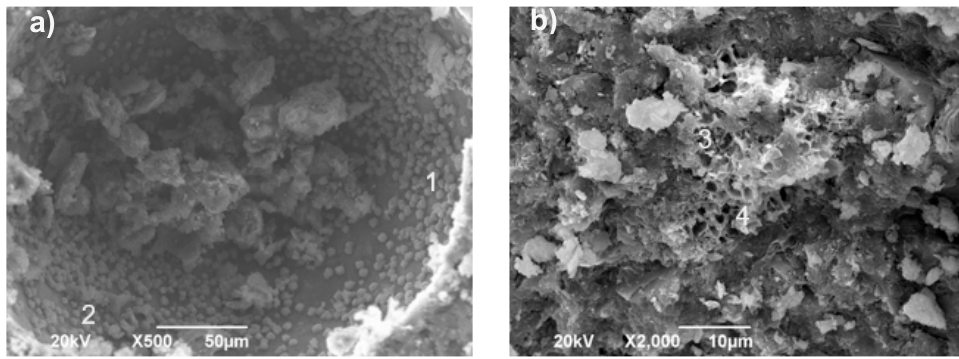
Figure 11. SEM micrographs of the pastes exposed to NaCl for a period of 180 days: ( a ) FA/OPC; and ( b ) OPC.